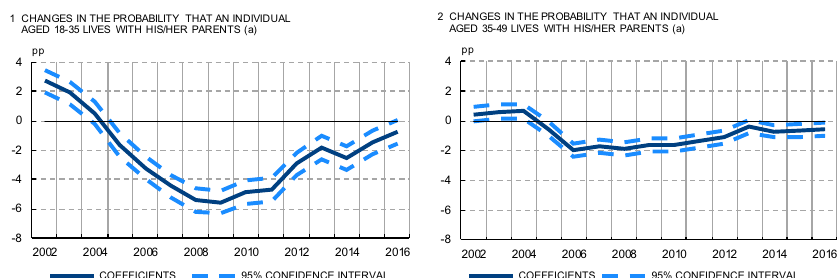
Fig. 11 Real insurance mechanisms available to households. a. Coefficients of the year dummy variable from a regression of the probability that an individual in the indicated age group lives with his/her parents, controlling for gender, age and educational level. EPA data for second quarter of each year (2002–2017). Reference year 2017. On average, within the period considered 50% of individuals aged 18–35 were living with their parents. This percentage falls to 8% when those aged 35–49 are considered. Source : National Statistics Institute